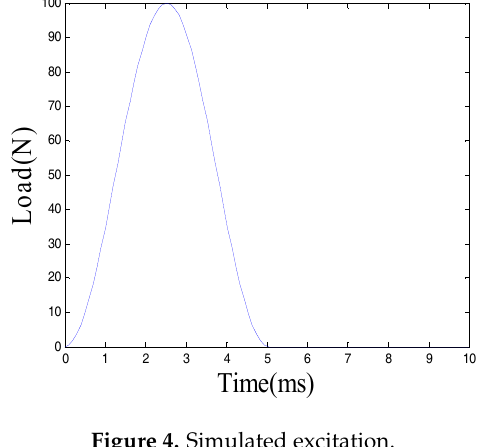
Figure 4. Simulated excitation.